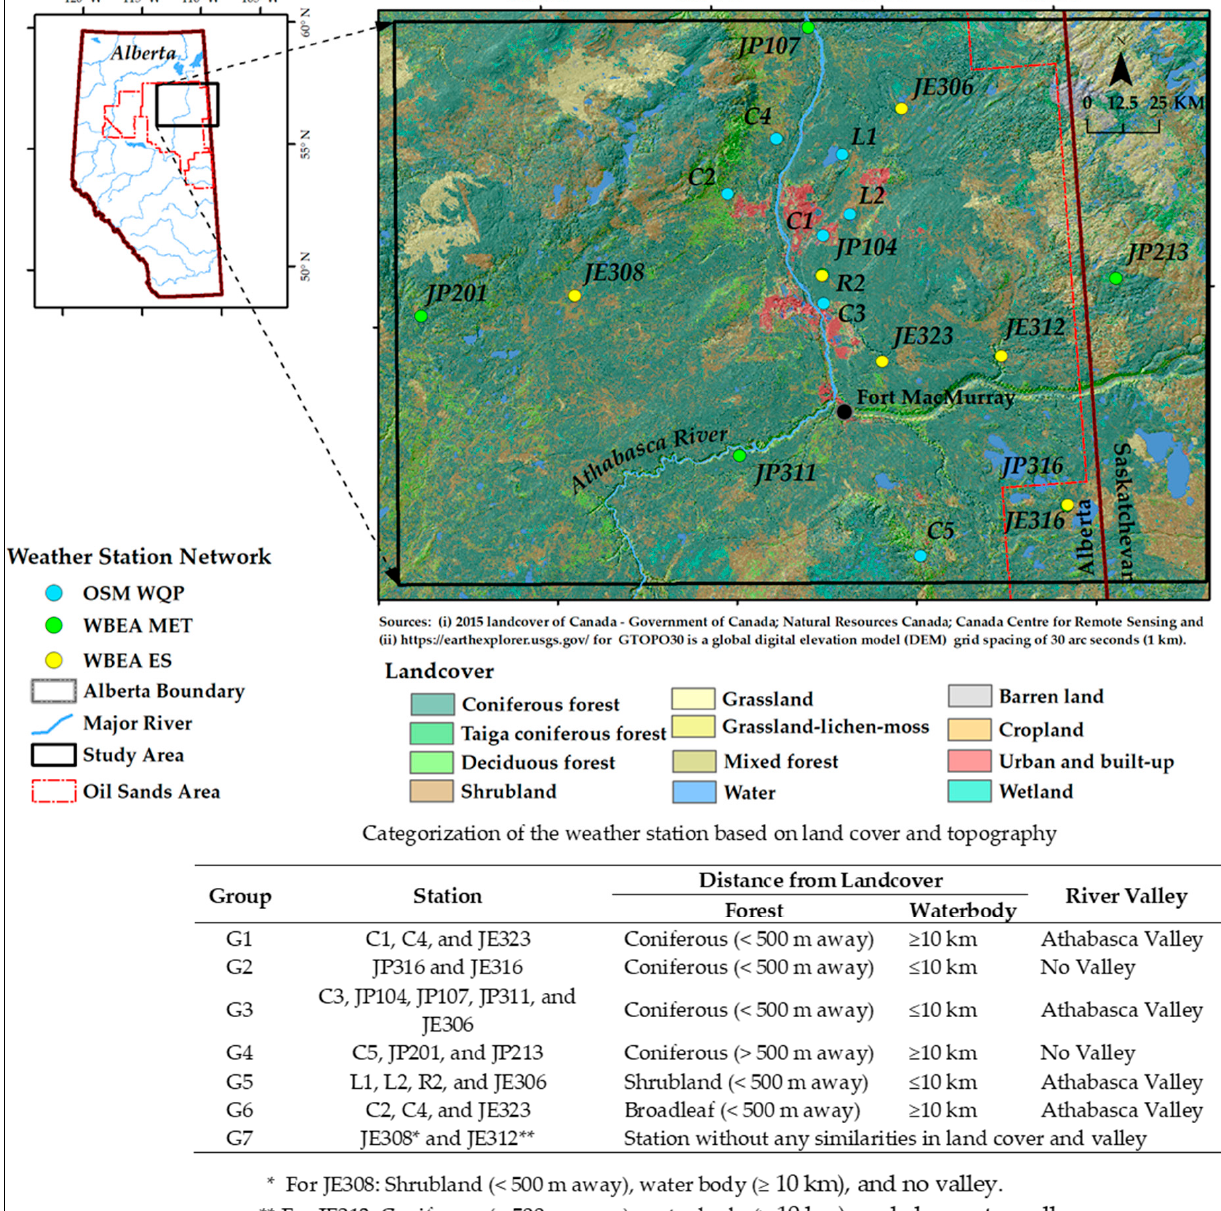
Figure 1. Location of stations belonging to different groups based on topographical features and networks that are being considered for analysis.